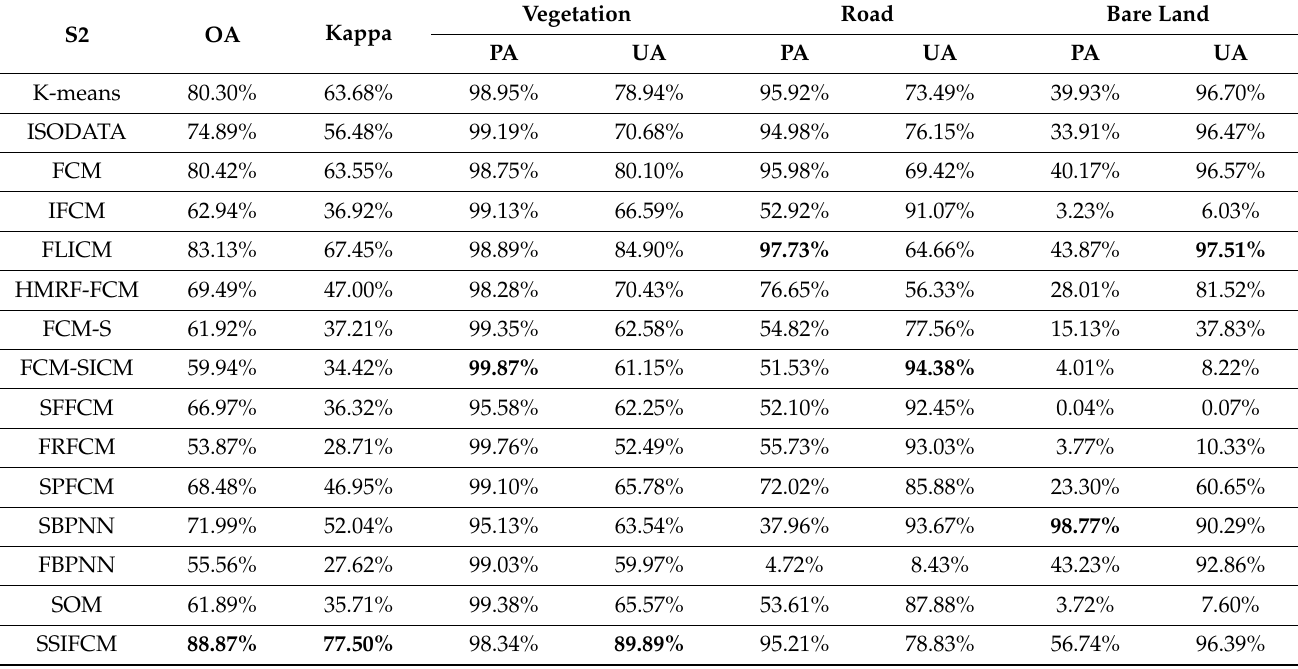
Table 6. Evaluation of S2 image classification results.